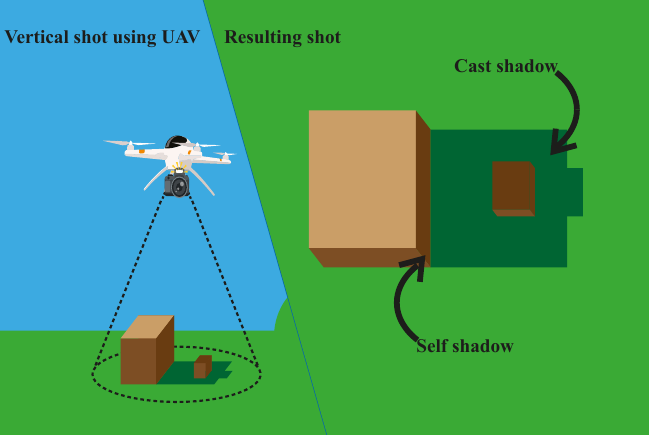
Figure 2. Image capturing